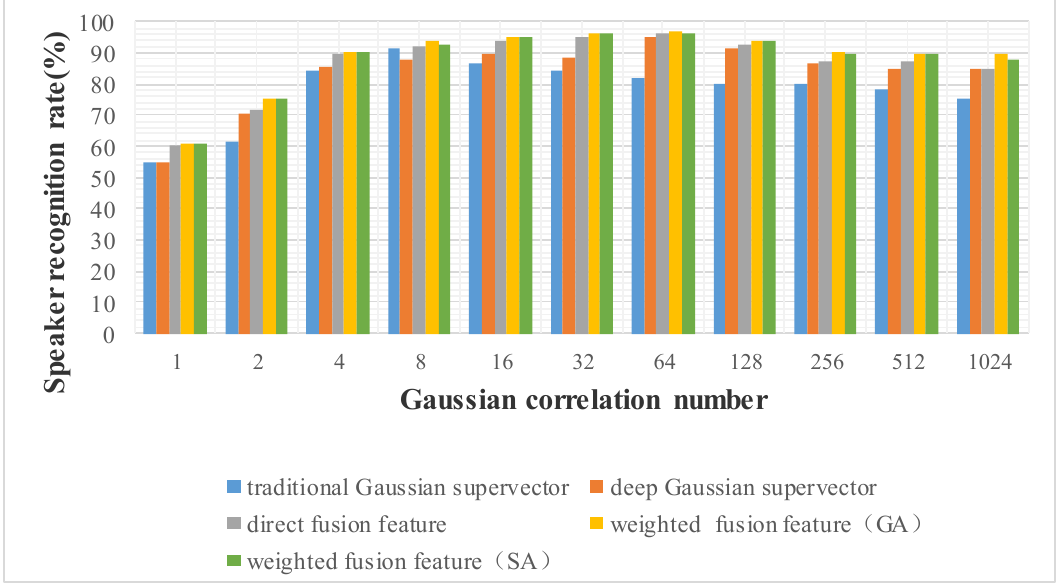
Figure 13. Speaker recognition rate based on different types of features (20